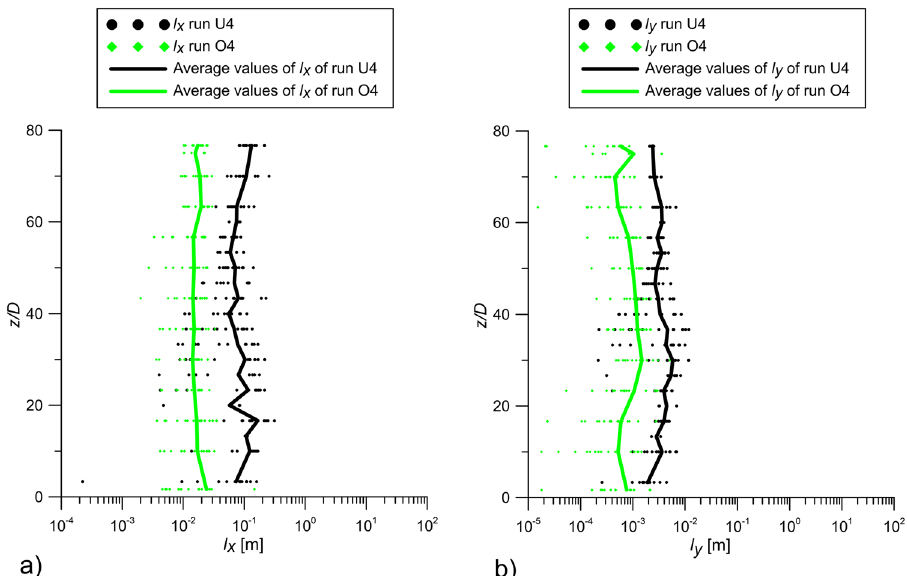
Figure 6. Values of l x and l y of runs U4 and O4 with the line of the averaged-values.